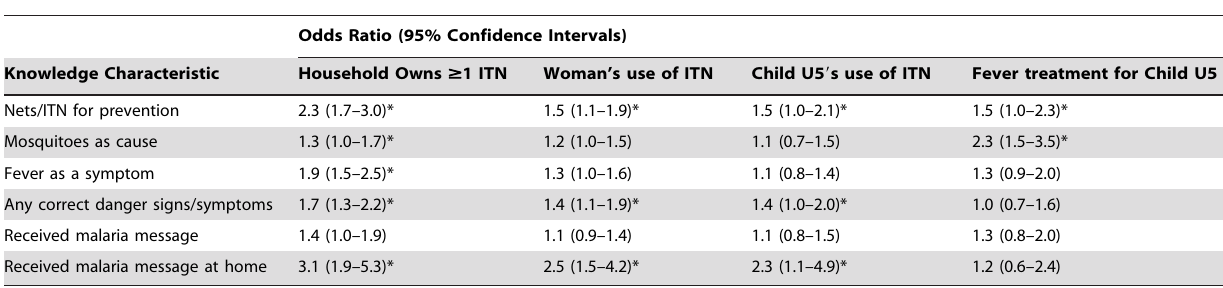
Table 3. Univariate analysis of aspects of malaria knowledge and its association with specific health-related behaviors.